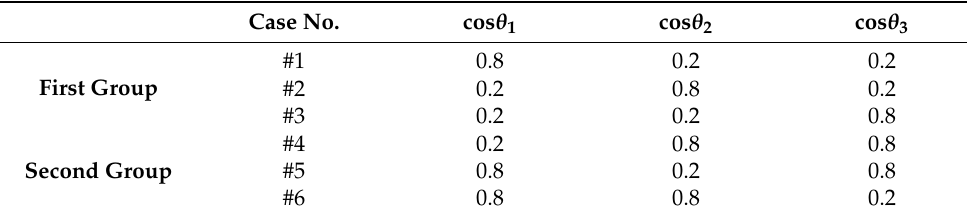
Table 1. Cases of random variation in wetting strength. Case No.